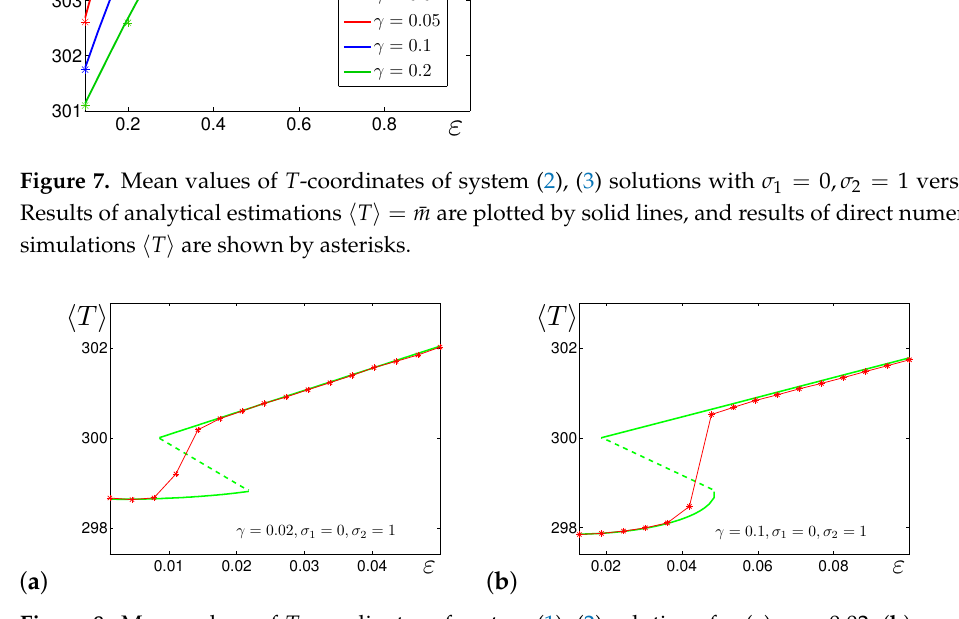
Figure 8. Mean values of T -coordinates of system (1), (2) solutions for ( a ) γ = 0.02, ( b ) γ = 0.1, for additive noise with σ 1 = 0, σ 2 = 1. Results of analytical estimations are plotted by solid lines, and results of direct numerical simulations are shown by